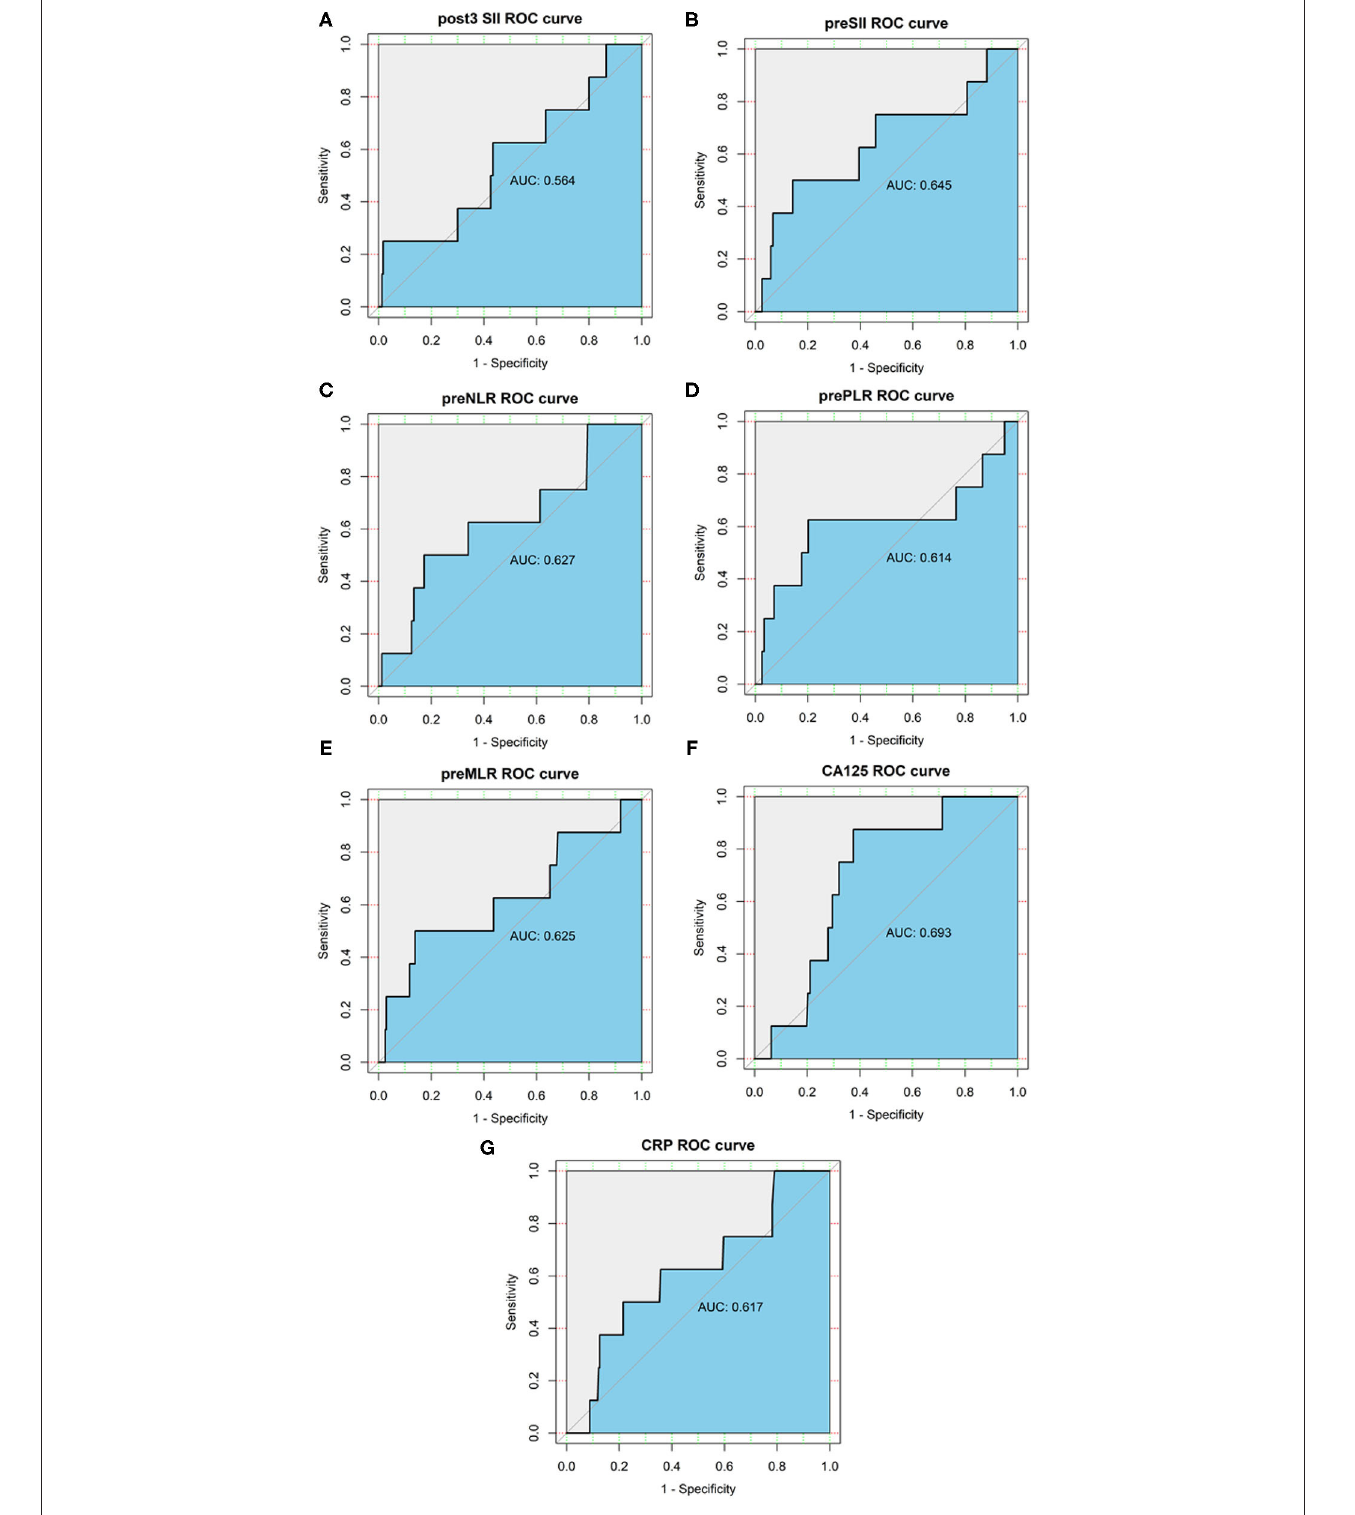
FIGURE 2 | Receiver operating characteristics (ROC) curve analysis of the preoperative SII, NLR, PLR, MLR, CRP, CA125, and postoperative SII. (A) ROC curve analysis of the postoperative SII for OS in endometrial cancer patients. (B) ROC curve analysis of the preoperative SII for OS in endometrial cancer patients. (C) ROC curve analysis of the preoperative NLR for OS in endometrial cancer patients. (D) ROC curve analysis of the preoperative PLR for OS in endometrial cancer patients. (E) ROC curve analysis of the preoperative MLR for OS in endometrial cancer patients. (F) ROC curve analysis of the preoperative CA125 for OS in endometrial cancer patients. (G) ROC curve analysis of the preoperative CRP for OS in endometrial cancer patients.